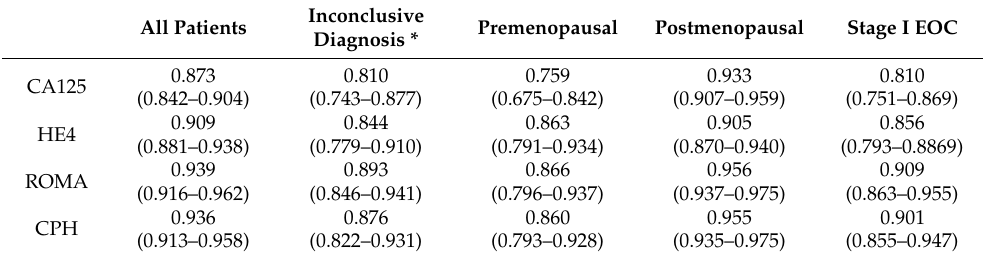
Table S1 summarizes the main findings of ROC analysis. Table 2. ROC analysis of Ca125, He4, ROMA and CPH for diagnosis of EOC or MCO. Area under the curve (95% CI).